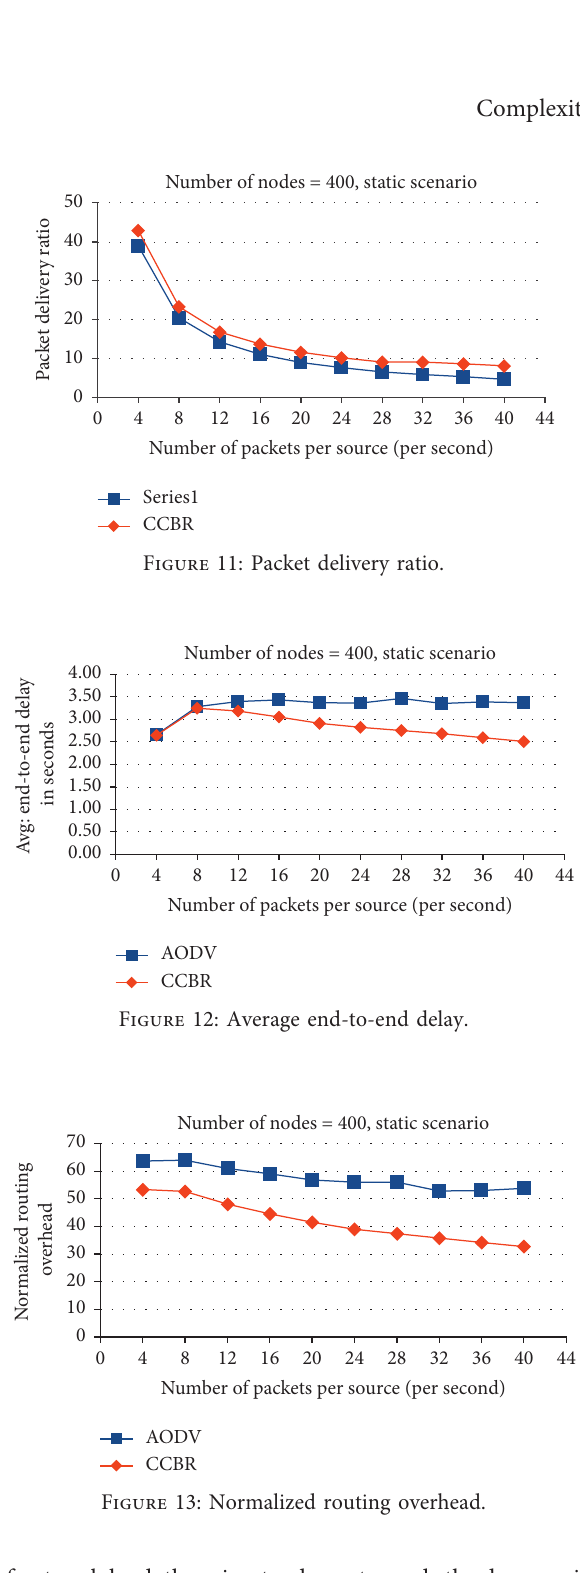
Figure 10: Normalized routing overhead.